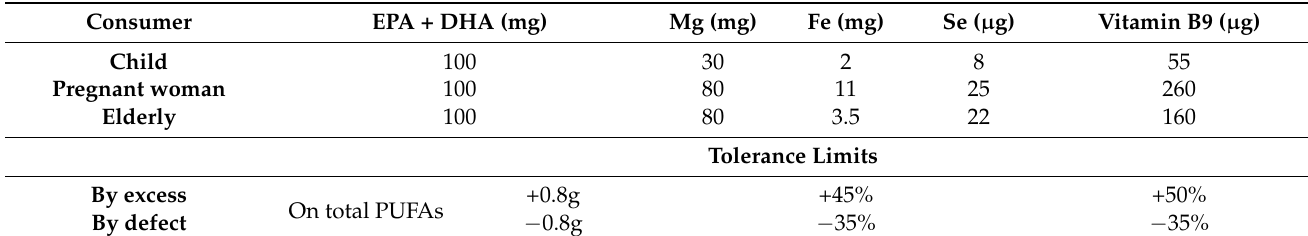
Table 1. Amounts of fortifying nutrients expected per 100 g of chicken burger intended for consumers such as children, pregnant women and elderly. Relative tolerance limits established by the guidance document for the control of compliance with Regulation (EU) No 1169/2011 are also reported. EPA: eicosapentaenoic acid; DHA: docosahexaenoic acid. Consumer EPA + DHA (mg)